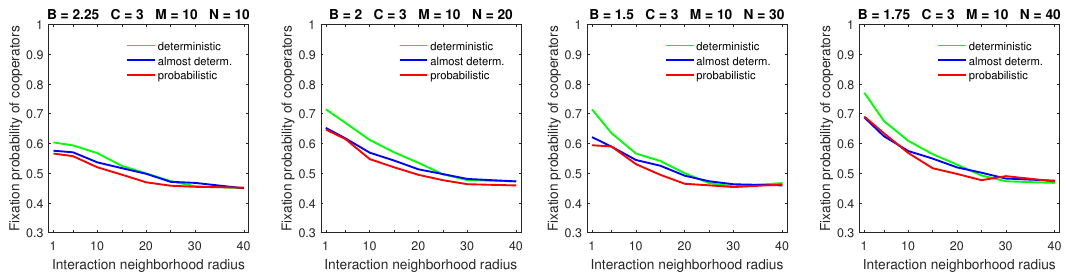
Figure 11. Deterministic dispersal results in higher fixation probabilities of cooperators for a high mobility rate and a medium dispersal range. In all graphs, R = 3.